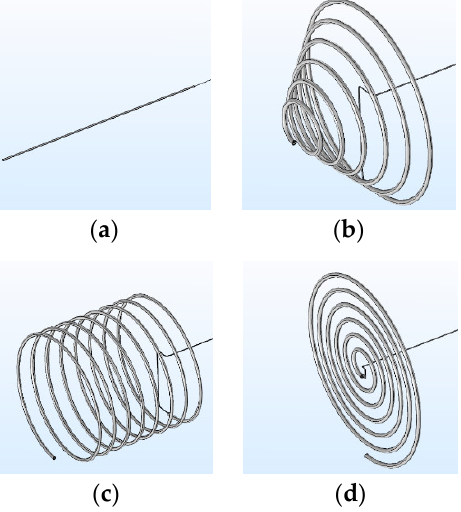
Figure 8. Four different shapes of transfer structures: ( a ) Linear; ( b ) Conical; ( c ) Cylindrical; ( d ) Planar.